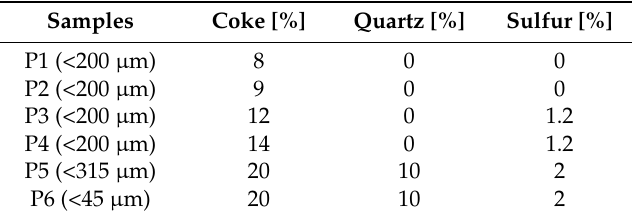
Table 2. Composition of the sample powder